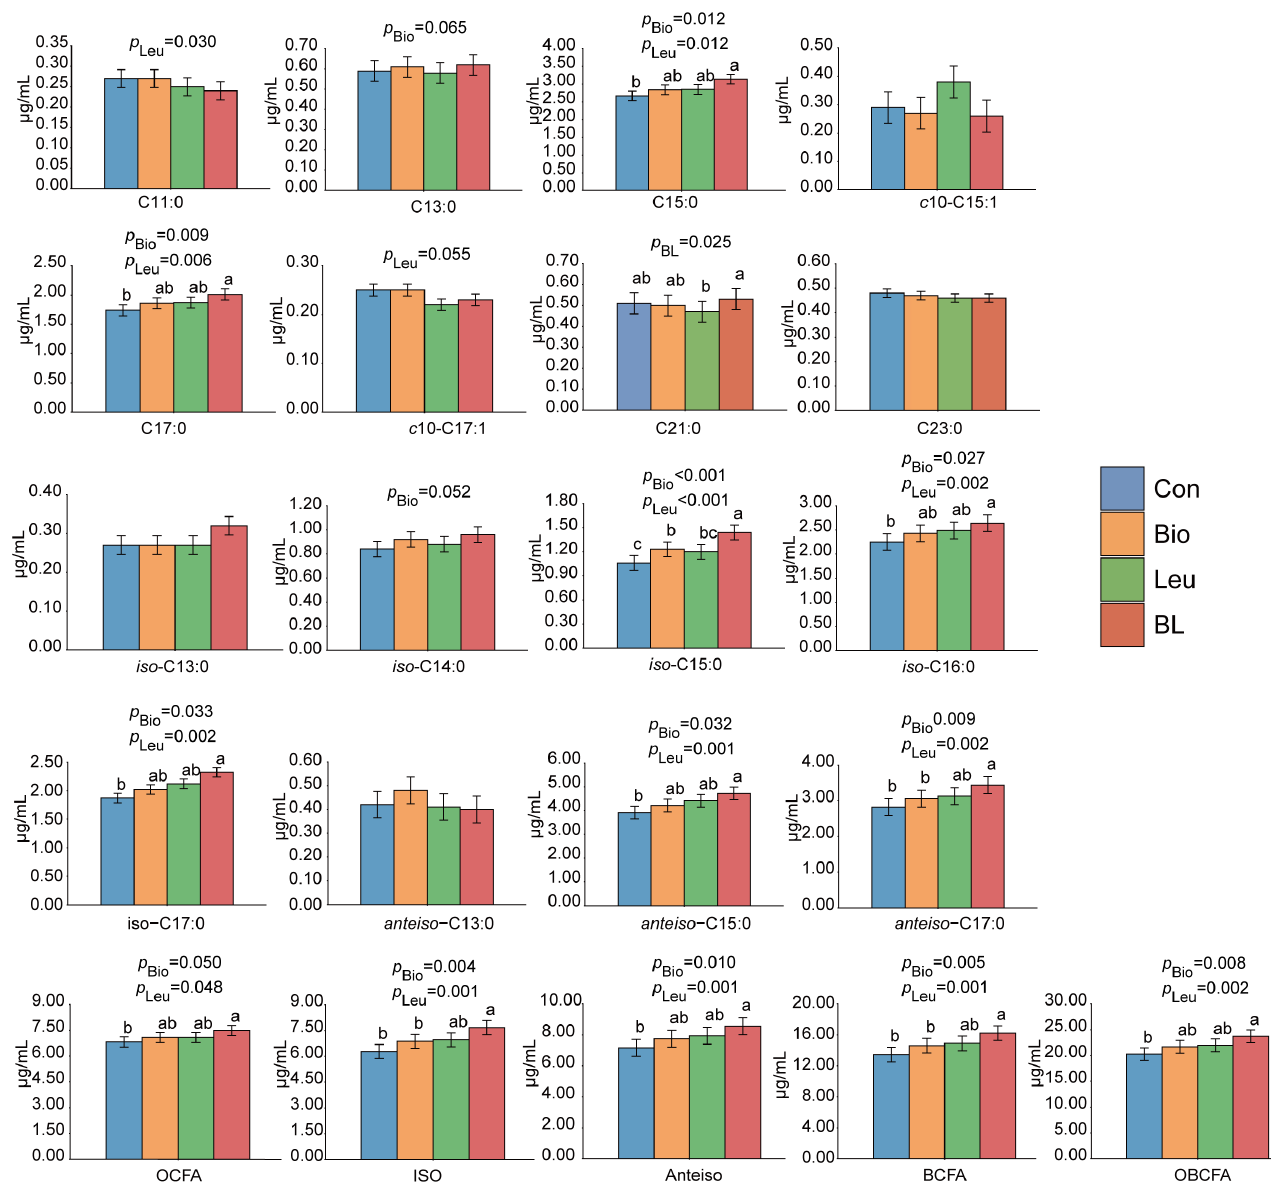
Figure 2. Effects of biotin and leucine supplementation on OBCFA concentration in vitro. Con, control group; Bio, biotin supplemented group; Leu, leucine supplemented group; BL, biotin and leucine combination group; anteiso -C15:0 and c 9-C14:1 could not be separated; OCFA = C11:0 + C13:0